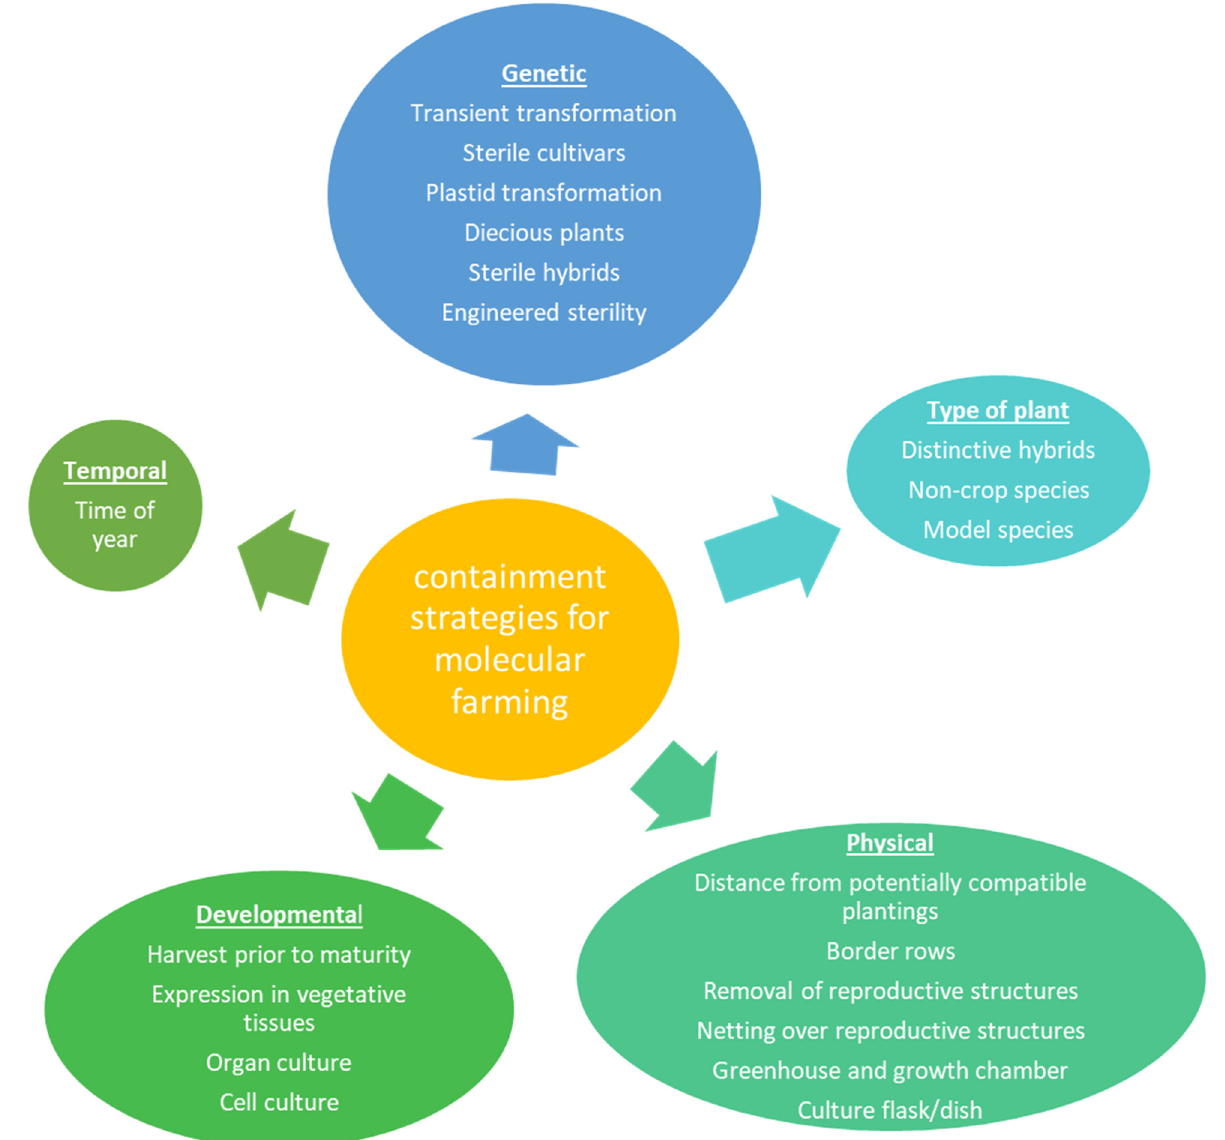
Figure 1. containment strategies for molecular farming. Figure 1. Containment strategies for molecular